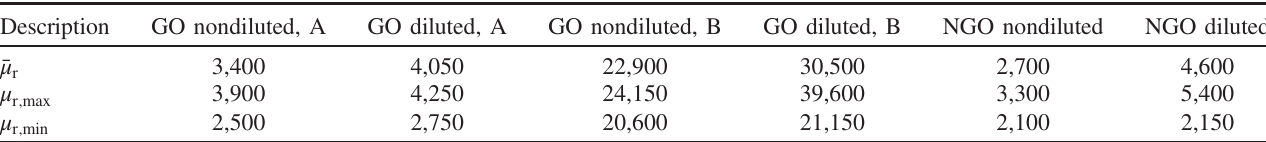
TABLE IX. Average, minimum and maximum permeability for nondiluted and diluted quadrupole magnet yokes calculated with measurement results from samples cut in the rolling direction.